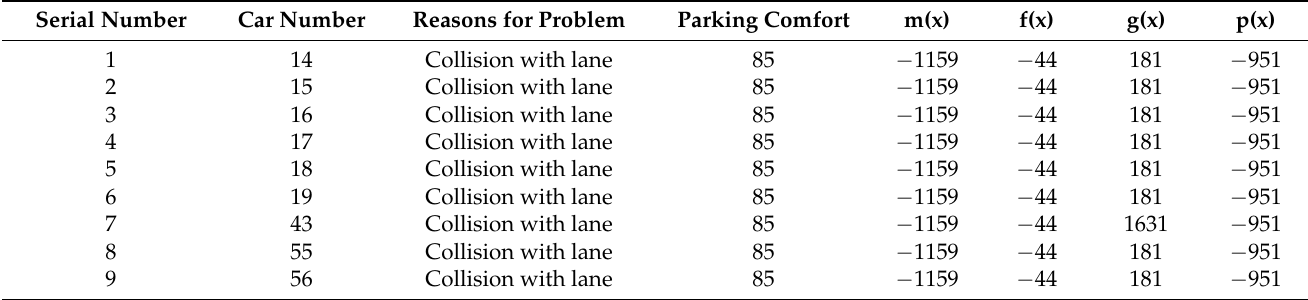
Table 1. Value of the parking space constraint model with poor